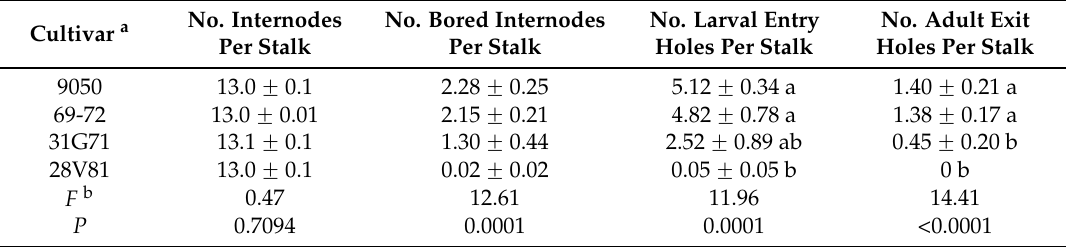
Table 4. Mean ( ˘ SE) numbers of internodes and Eoreuma loftini damage per corn stalk, n = 5 stalks/plot, Hidalgo County, TX, USA, 18 July 2011 [151]. Cultivar